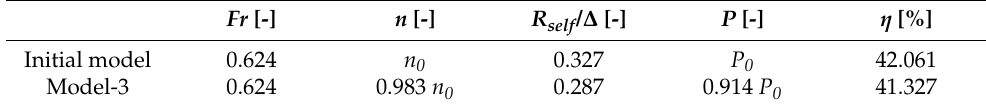
Figure 24. The resistance reduction effect of the ultimate resistance improvement model.